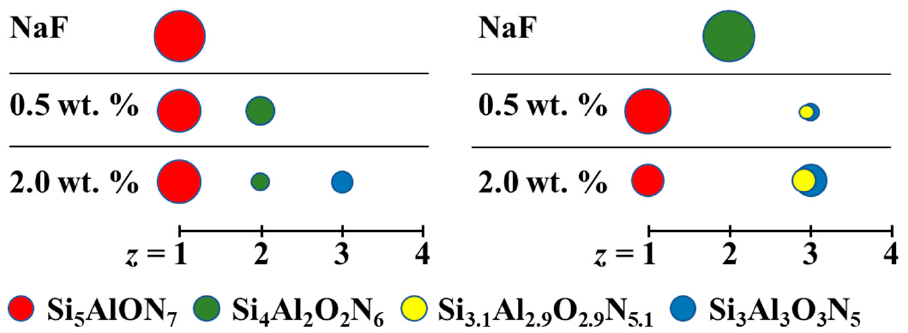
Figure 7. The changes in composition of Si 5 AlON 7 and Si 4 Al 2 O 2 N 6 under the high-temperature sintering with NaF.